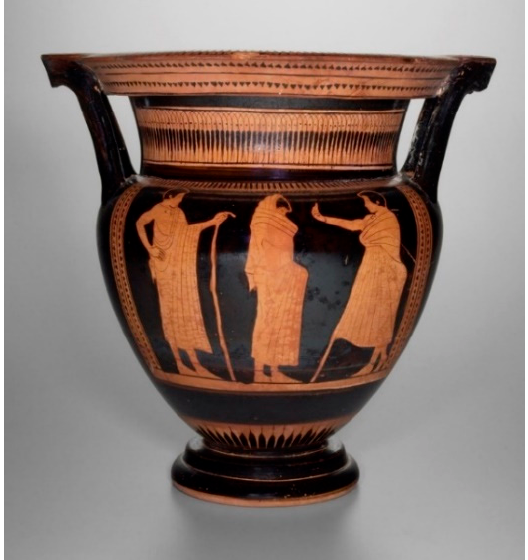
Figure 5. Reverse of Figure 4. New Haven, Yale University Art Gallery 1933.175. Photo courtesy Yale University Art Gallery. https://artgallery.yale.edu/collections/objects/5658. In the public domain. 475-450 BCE.